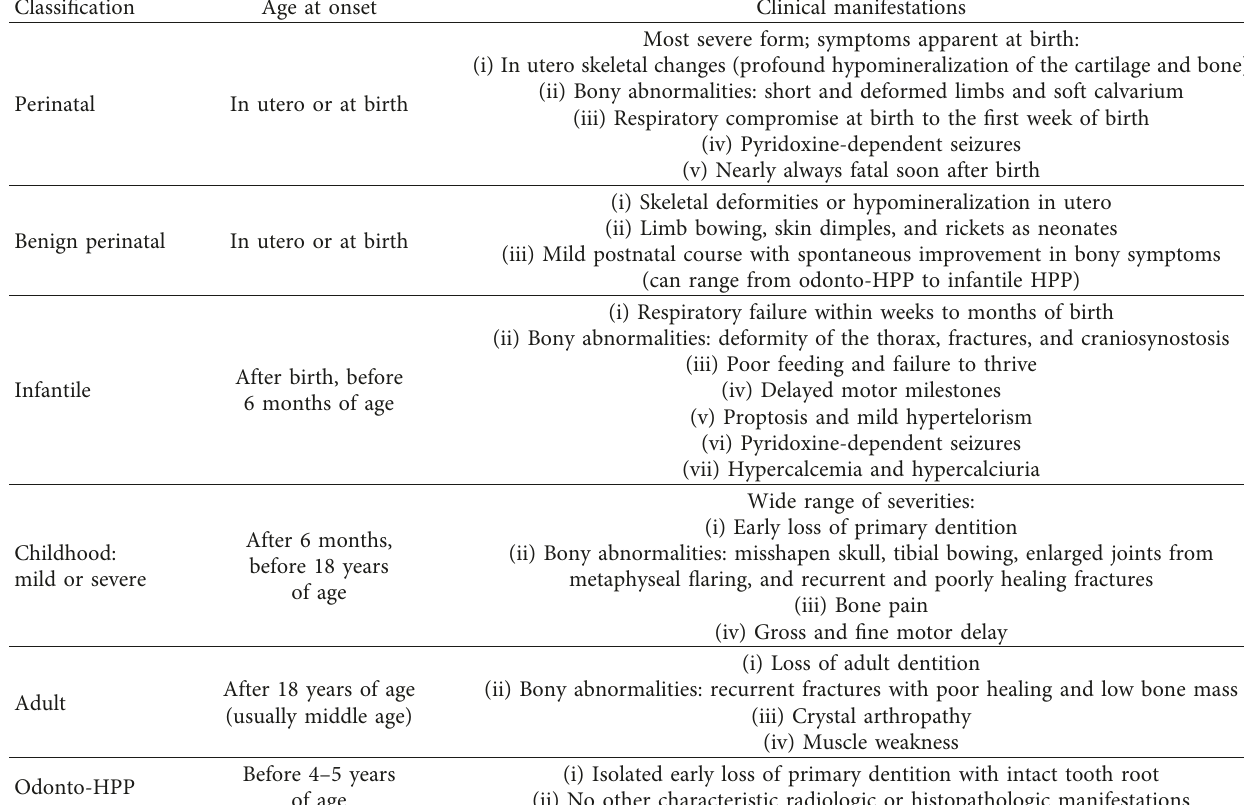
Table 1: Classification and clinical manifestations of HPP [1–3, 6, 8,